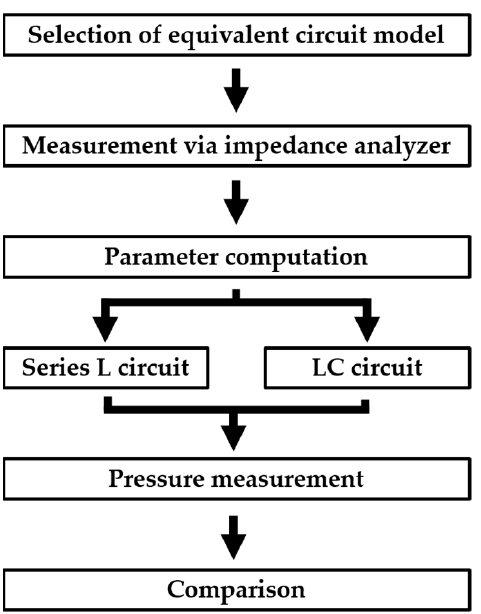
Figure 2. Flow chart of impedance matching process.